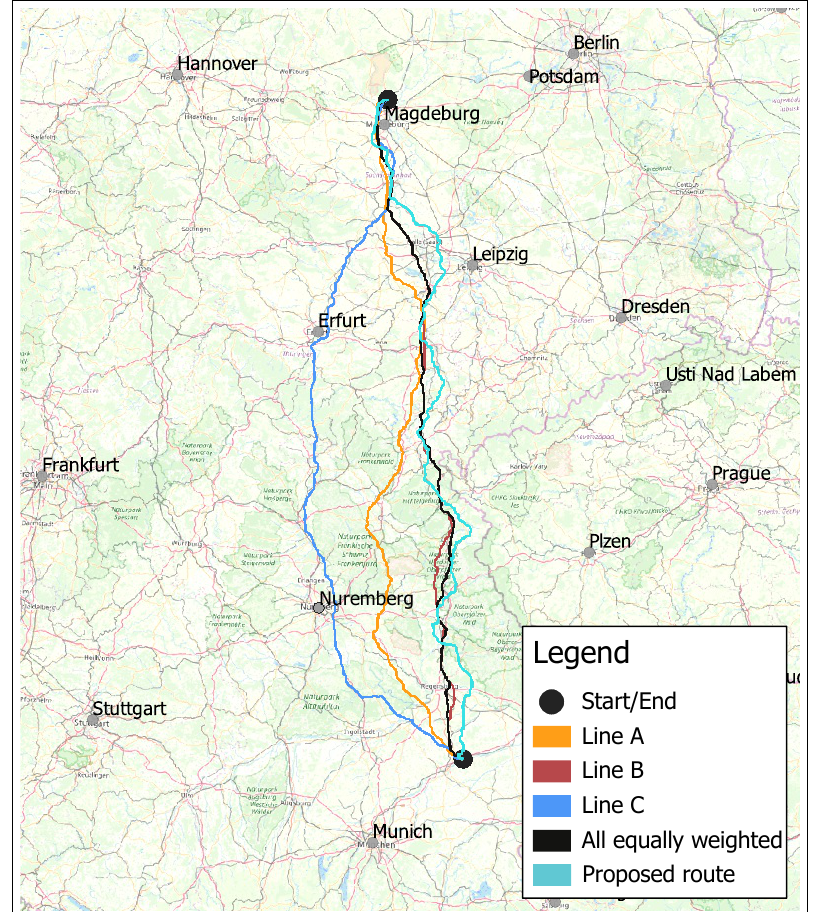
Figure A1. Example routes for the DC GER project, showing the routes which correspond to the weights of points A, B, and C in Figure 7, and the route with uniform weighting factors. Furthermore, it shows the route corridor that has been proposed by the responsible grid transmission system operators. Own illustration.